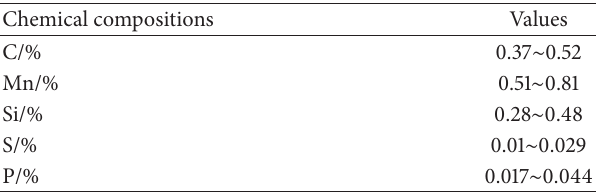
Table 1: Chemical compositions of 45 steel bar material.